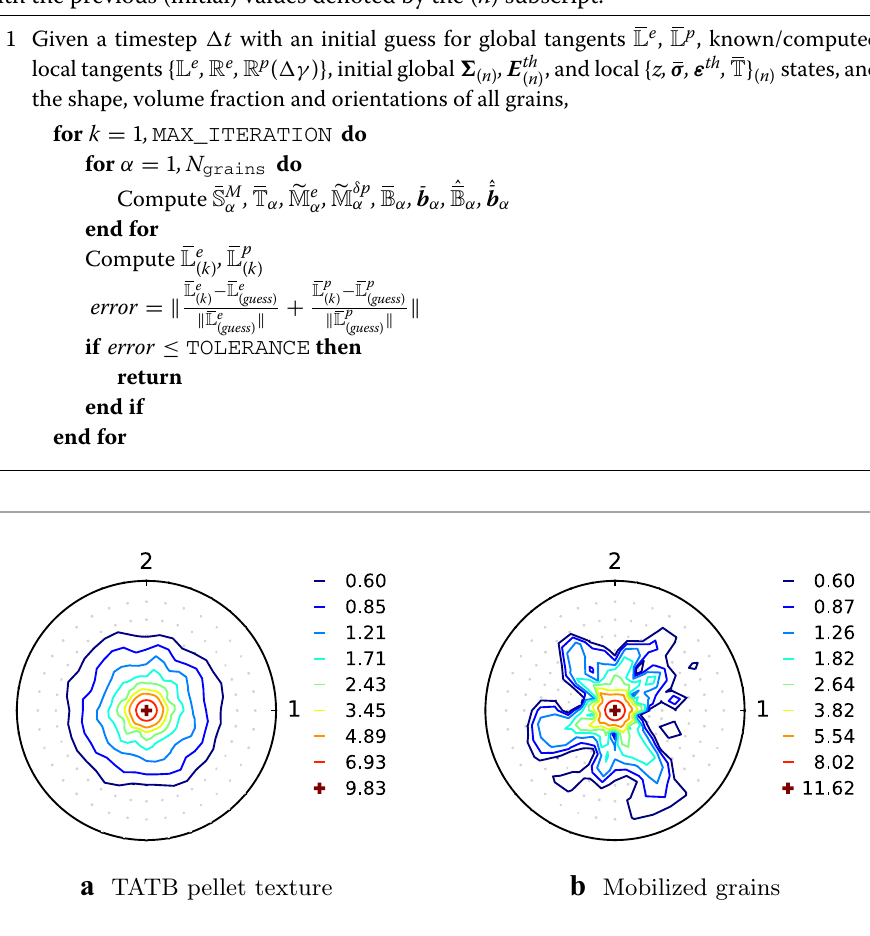
Algorithm 2 Iterative self-consistent solution of global tangents and local concentration tensors. The ( n + 1) subscript to denote current quantities is dropped here for brevity, with the previous (initial) values denoted by the ( n ) subscript.